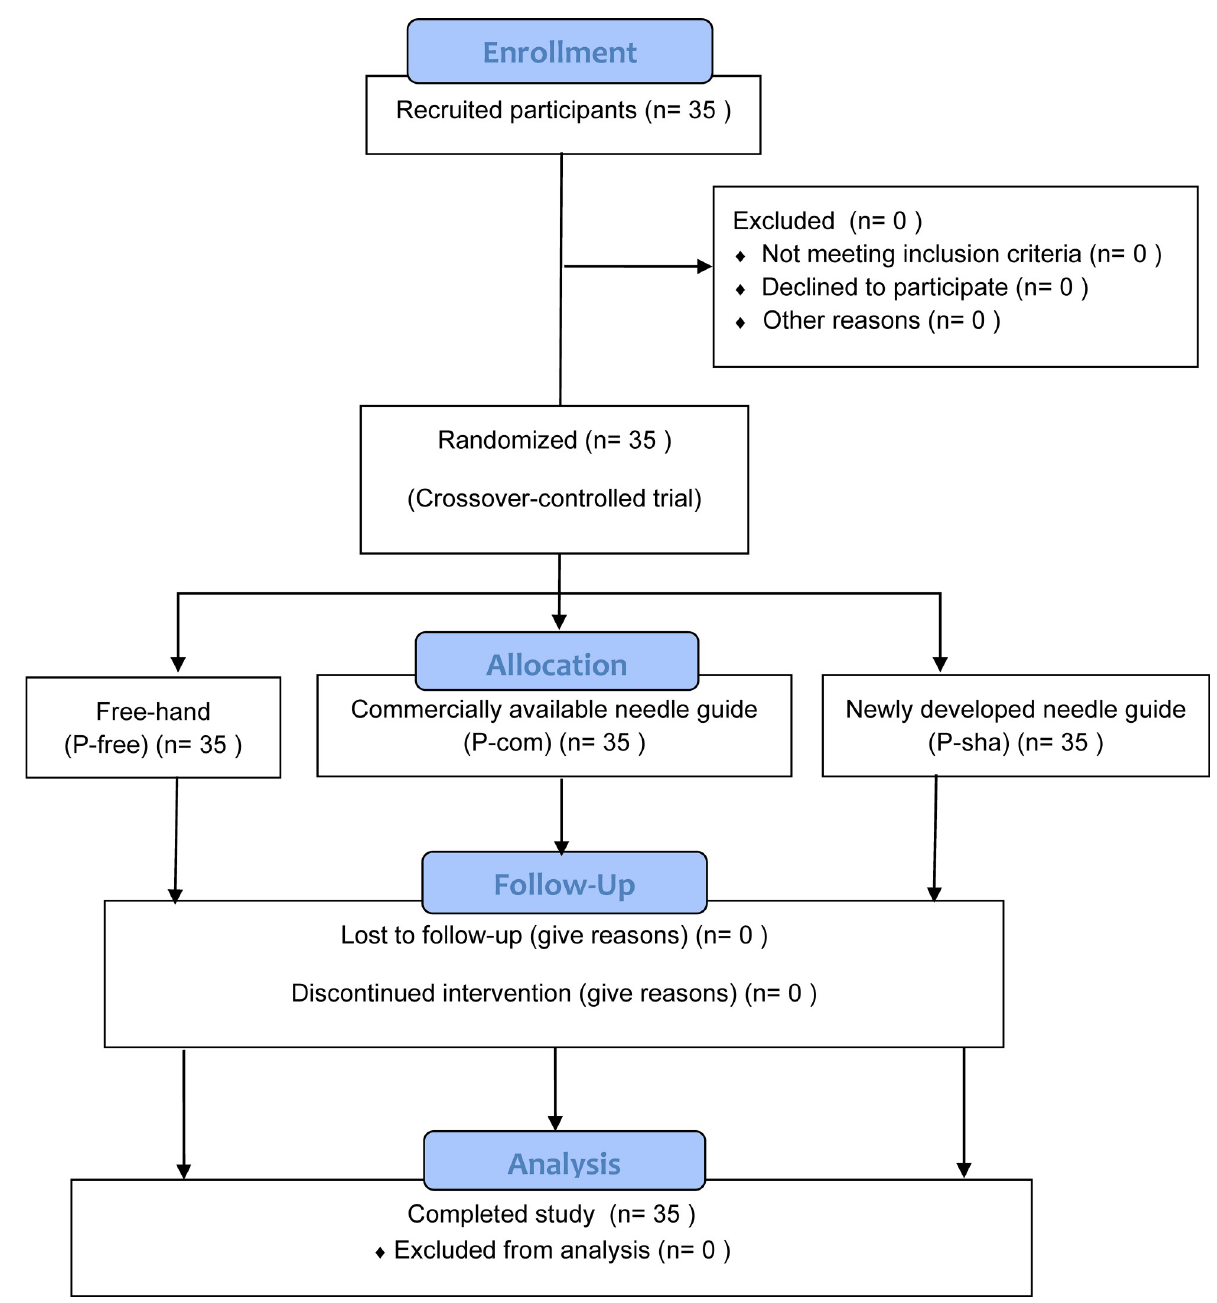
Fig 1. Consort flow